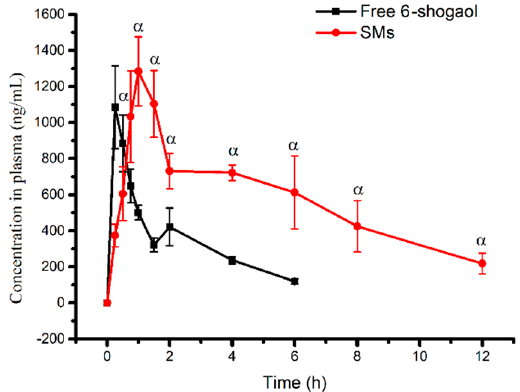
Figure 4. Mean plasma concentration-time profiles of 6-shogaol after oral administration of a single 100 mg/kg dose each of SMs and free 6-shogaol to rats. Results are presented as the Mean ± SD (n = 5). α P < 0.05, SMs versus free 6-shogaol. Table 2. Pharmacokinetic parameters of free 6-shogaol and 6-shogaol loaded micelles (SMs) after oral administration in rats (mean ±